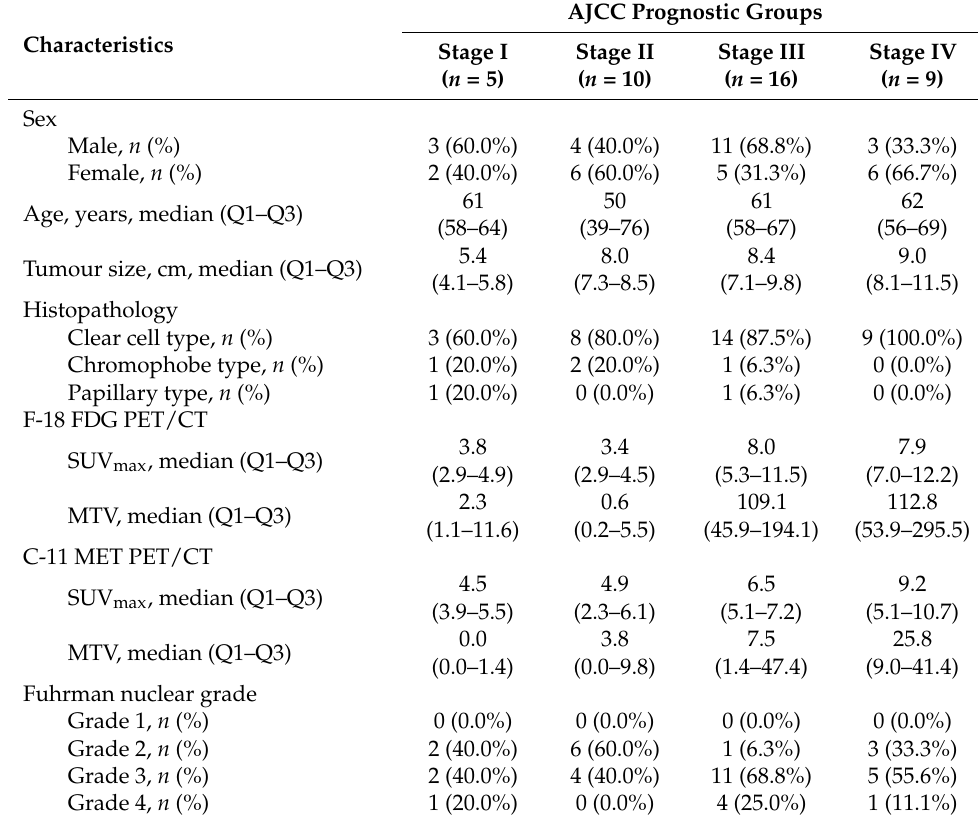
Table 1. Clinical characteristics of the